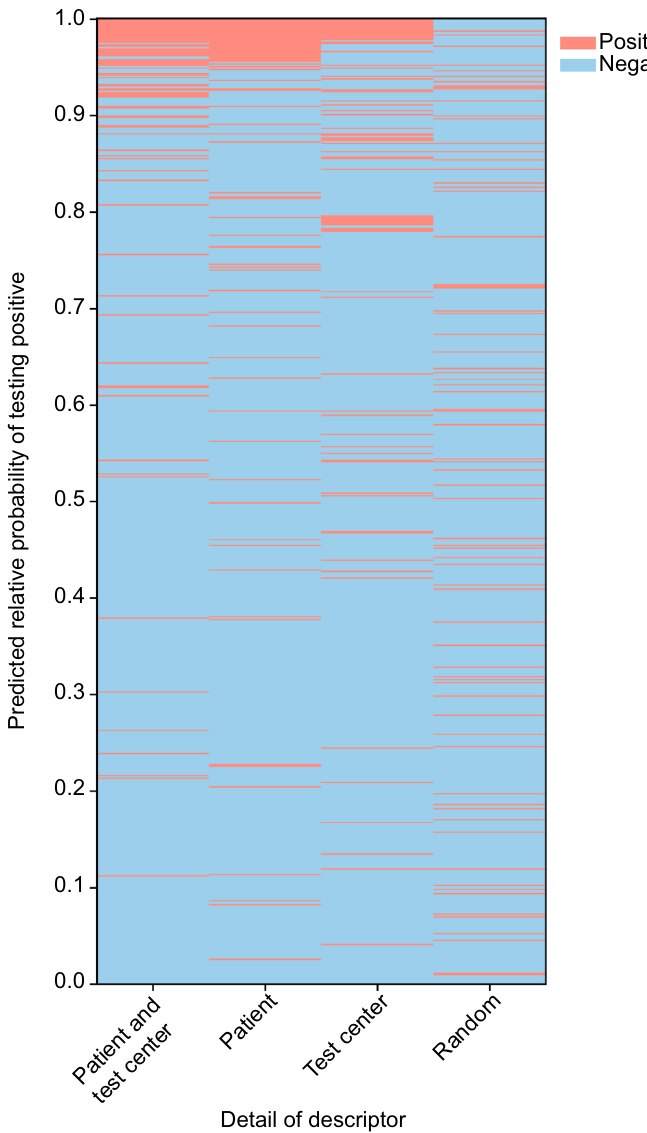
Figure 3. Comparison between Smart Pooling and Random ordering. Left: samples arranged by Smart Pooling. Right: random ordering of samples. Note that Smart Pooling groups positive samples generating long groups of negative samples, reducing the number of times it is necessary to perform the second stage of Dorfman’s testing, increasing the